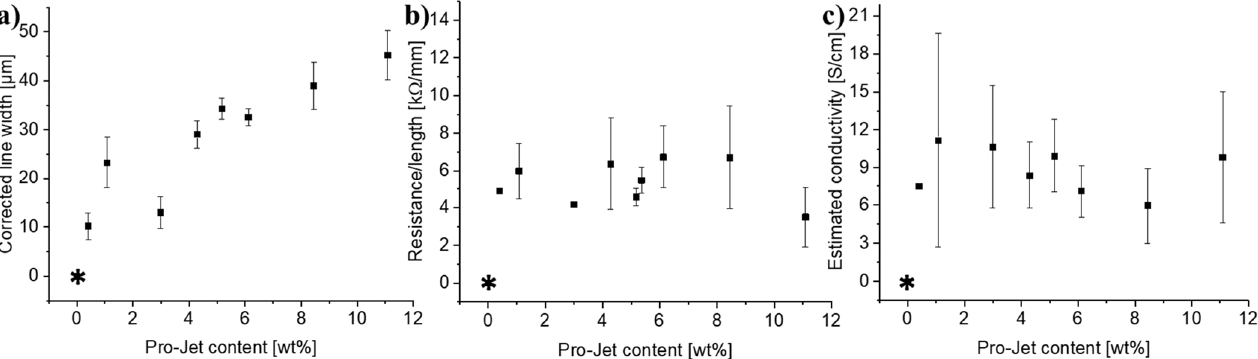
Figure 8. The influence of the Pro-Jet content on ( a ) corrected line width ( b ) line resistance, and ( c ) estimated conductivity. Error bars were computed using the law of error propagation ( n = 4). The asterisks (*) signify that conductive lines could not be formed.